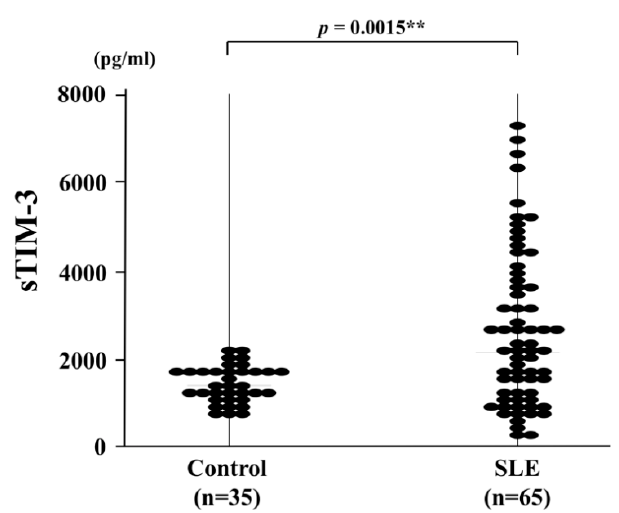
Figure 1. Serum sTIM-3 levels in SLE patients ( n = 65) and healthy controls ( n = 35). Soluble TIM-3 levels of SLE patients were significantly higher than those in healthy controls. Median sTIM-3 levels (bar) are displayed and statistical analysis was conducted using the Mann–Whitney’s U test. sTIM-3: soluble T cell immunoglobulin and mucin-domain-containing molecule 3, SLE: systemic lupus erythematosus. ** p < 0.01 is considered as statistically significant.